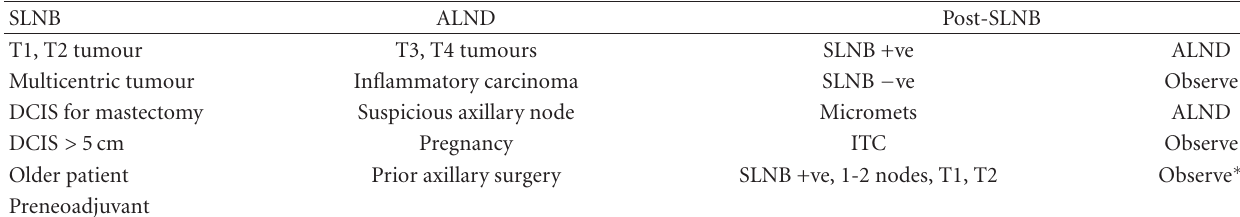
Table 1: Recommendations of SLNB, ALND, and treatment after SLNB.